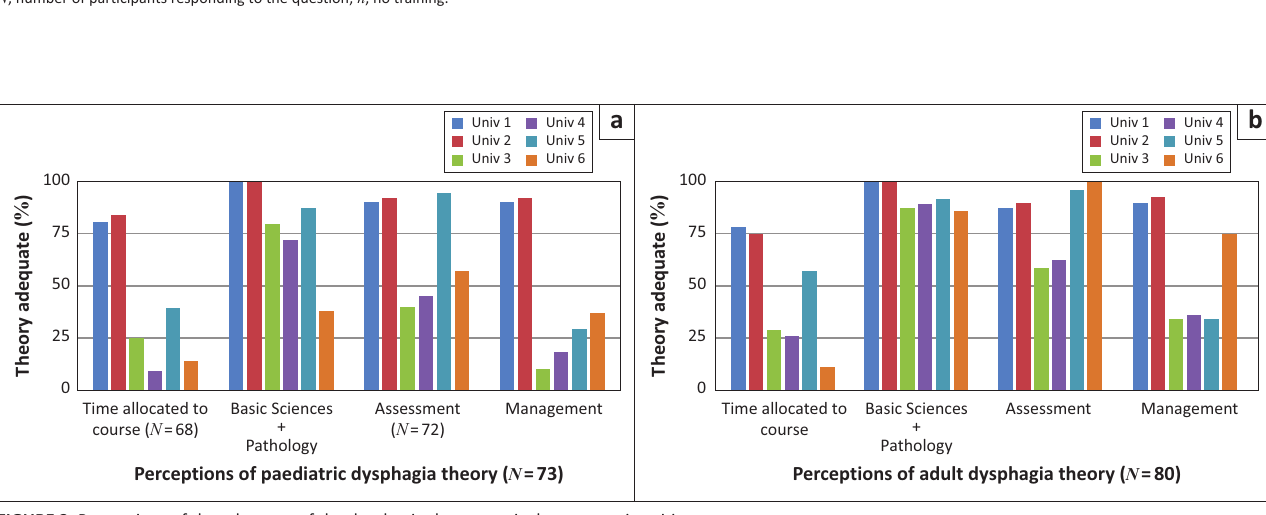
FIGURE 3: Perceptions of the adequacy of the dysphagia theory curricula across universities.